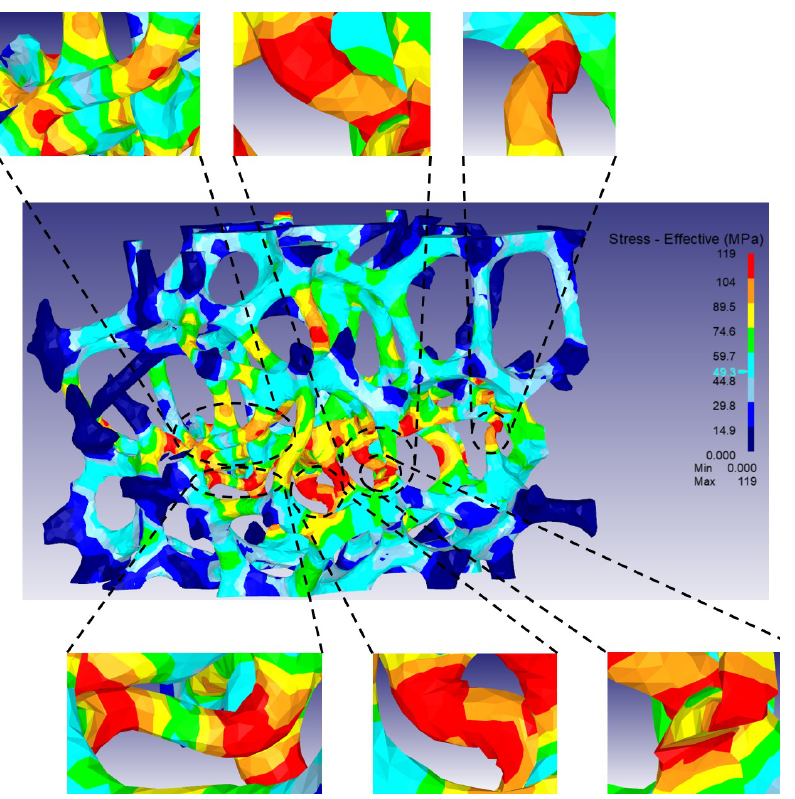
Figure 8: Snapshot of effective stress for 3D model domain of Specimen 1 at a strain of 0.15 Figure 8. Distribution of effective stress for 3D model domain of Specimen 1 at a strain of